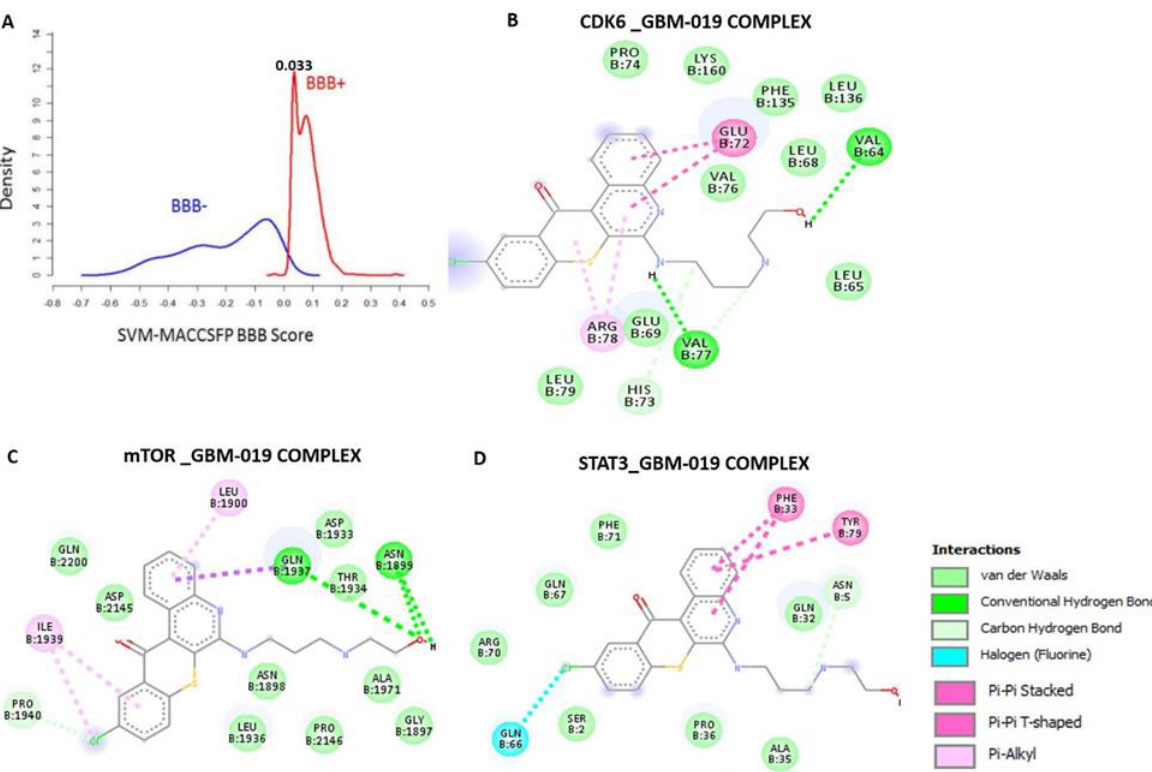
Figure 3. Blood–brain barrier permeation and molecular docking profiles of GBM-0N19 with STAT3, mTOR, and CDK6. ( A ) BBB permeation curve of GBM-N019 as measured by the support vector machine (SVM) and LiCABEDS algorithms of BBB prediction server. The two-dimensional (2D) representations of the ligand–receptor complexes, showing the interacting amino acid residues and the type of interactions occurring between the GBM-N019 and ( B ) CDK6 ( C ) mTOR and ( D ) STAT3.